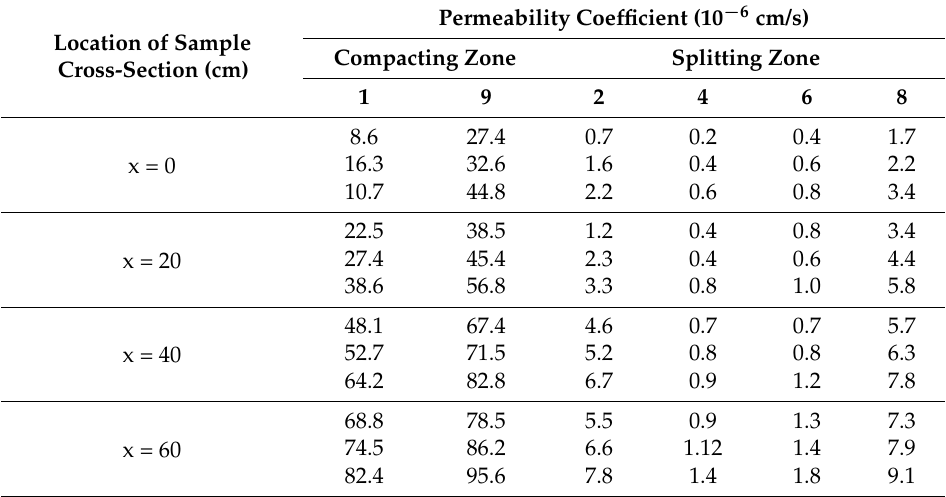
Table 5. Permeability coefficients.